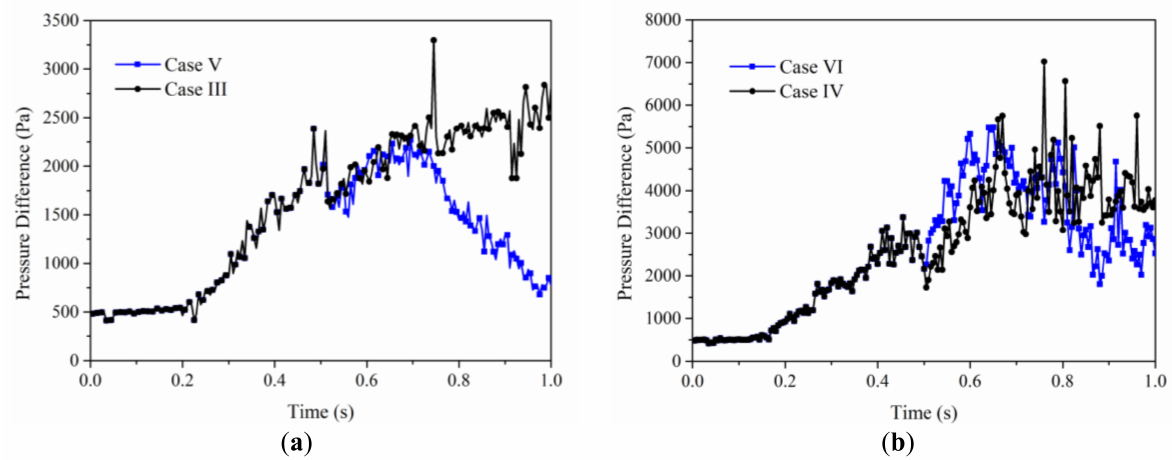
Figure 20. Comparison of pressure difference between slug injection and alternate injection with time: ( a ) small particles, ( b ) large particles.